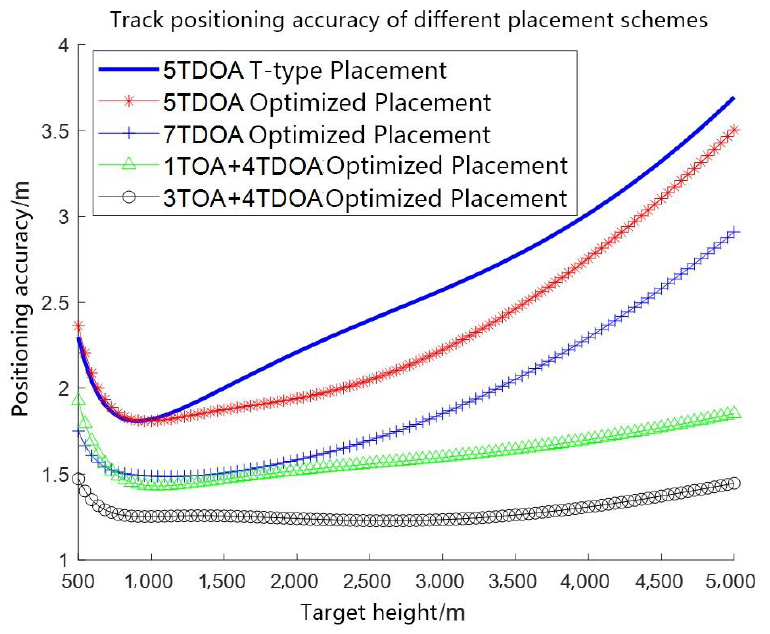
Figure 6. Target trajectory positioning accuracy of different station layout schemes.